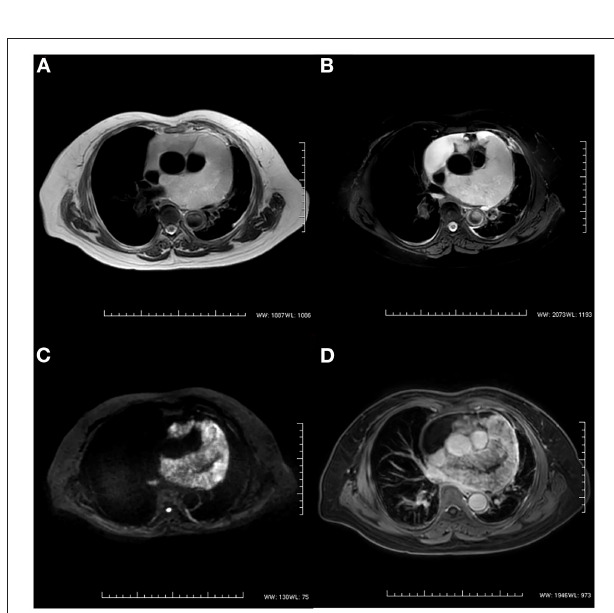
FIGURE 3 | Cardiac magnetic resonance imaging. (A) T2-weighted imaging showed an irregular mass in the pericardium. (B) The signal intensity of the mass was hyperintense on T2-weighted imaging with fat suppression. (C) The diffusion-weighted image was hyperintense. (D) The mass showed irregular enhancement with gadolinium injection on T1-weighted